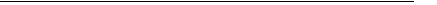
for the T 2 = 12 1